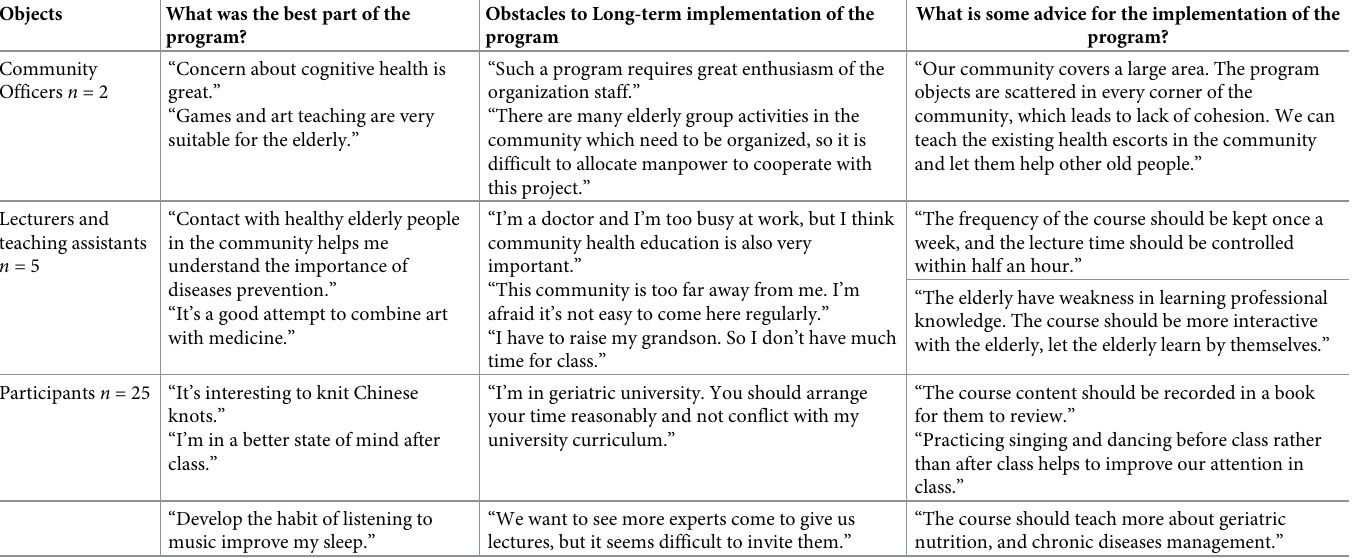
Table 4. Responses of key informant interviews with program related